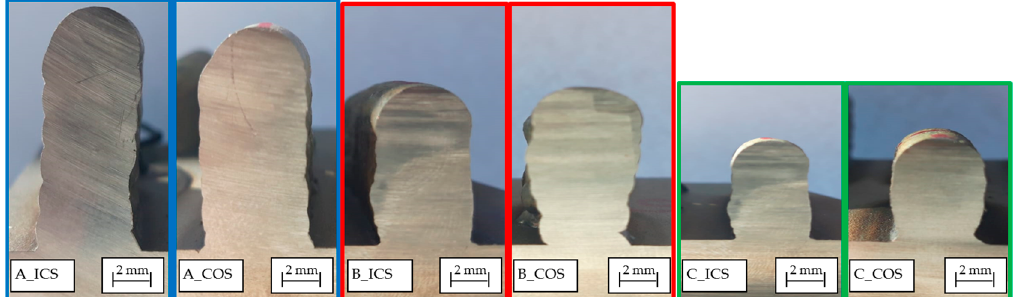
Figure 4. Traverse view of deposited wire + arc additive manufacturing (WAAM) wall by using three different processing parameters (A, B and C) with two different cooling strategies (interpass cooling strategy (ICS) and controlled overlay strategy (COS)) .